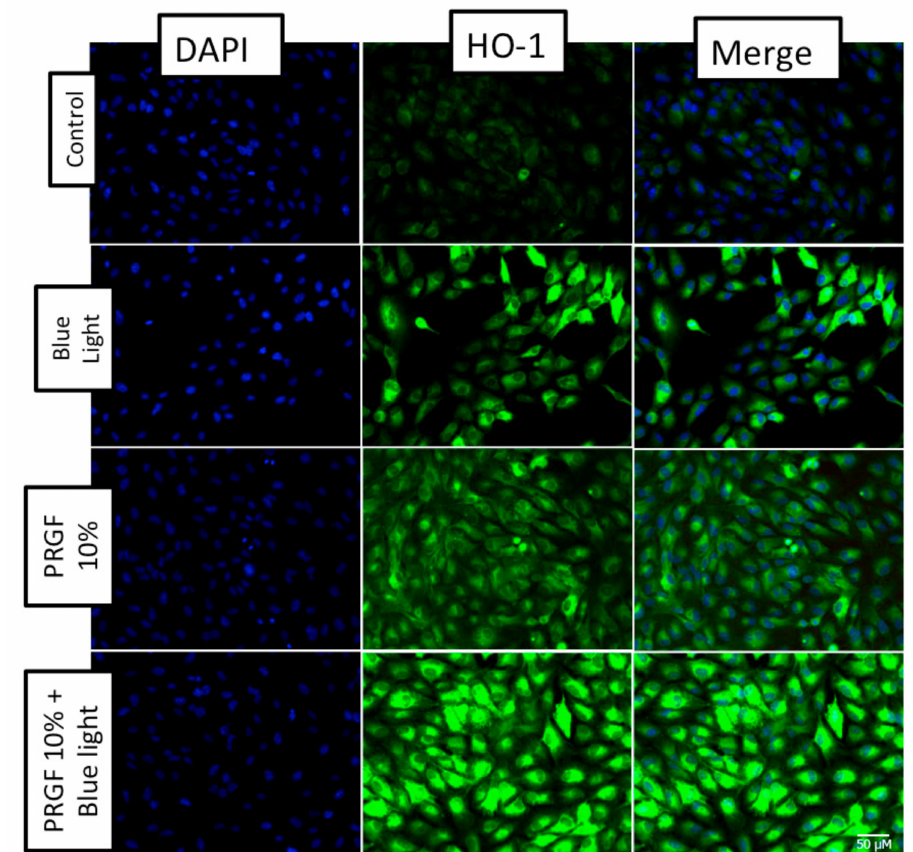
Figure 8. ARPE19 immunocytochemistry for HO-1 (green) and DAPI (blue) ( n = 4). The results showed that blue light increased HO-1 expression. In addition, PRGF intrinsically expressed HO-1 as compared with the control. PRGF combined with blue light also increased staining for HO-1. Scale = 50 µ